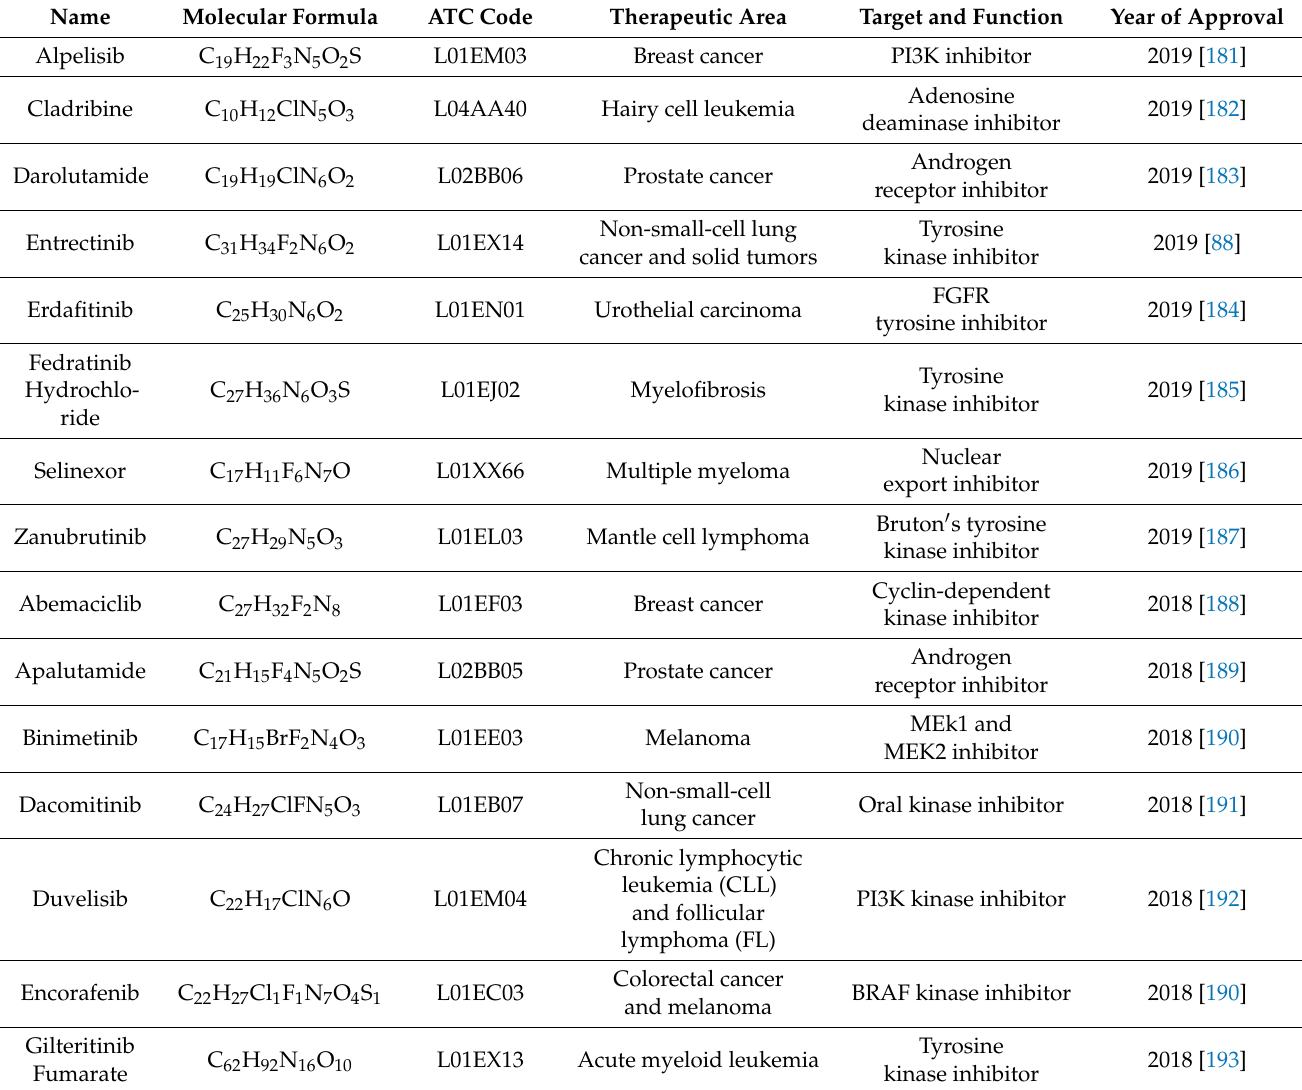
Table 4. The list of FDA-approved anticancer drugs from the National Cancer Institute